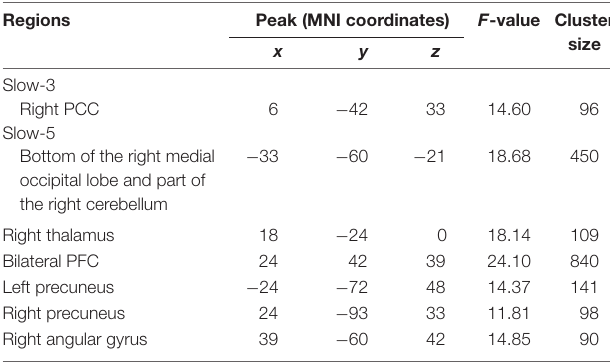
TABLE 2 | Regions showing group (MCI, NC) × state (resting, working memory task) interaction for ReHo in slow-3 and slow-5 bands. Regions